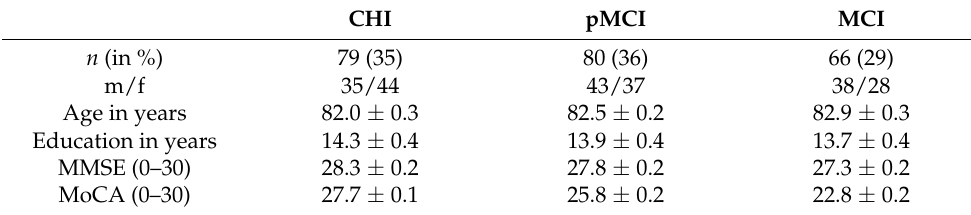
Table 1. Characteristics of the groups according to cognitive status. CHI pMCI MCI n (in %) 79